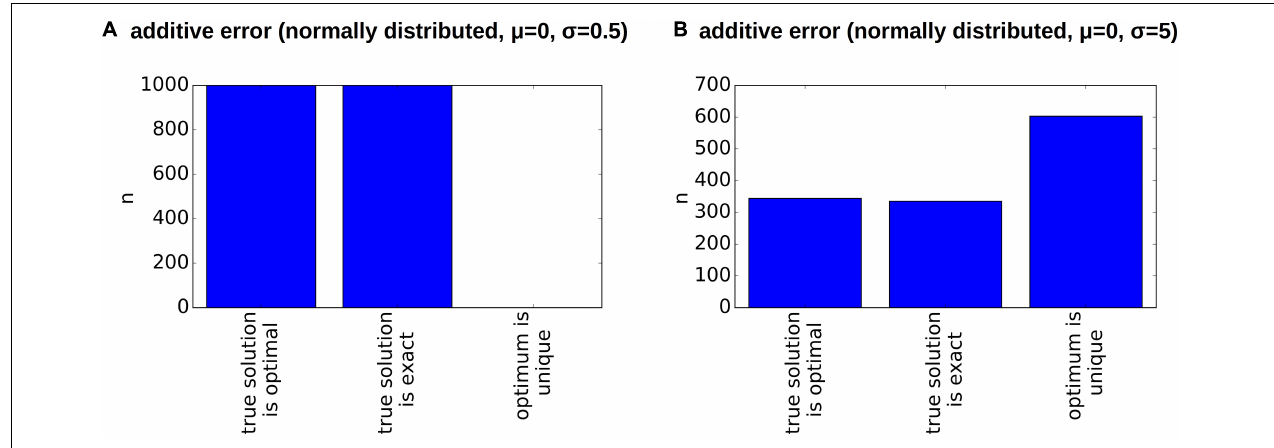
FIGURE 10 | Clonal hierarchies fitting the relaxed dataset. Here, we consider the relaxed version of the dataset from Patient 7. The relaxation makes the reconstruction more robust to errors. Additive perturbations of the VAF were drawn from a normal distribution with mean zero and standard deviation 0.5% (A) or 5% (B) . In comparison to Figures 8B,C the true hierarchy is in many cases an optimal hierarchy. drawn from a multinomial distribution with probabilities p i = f i